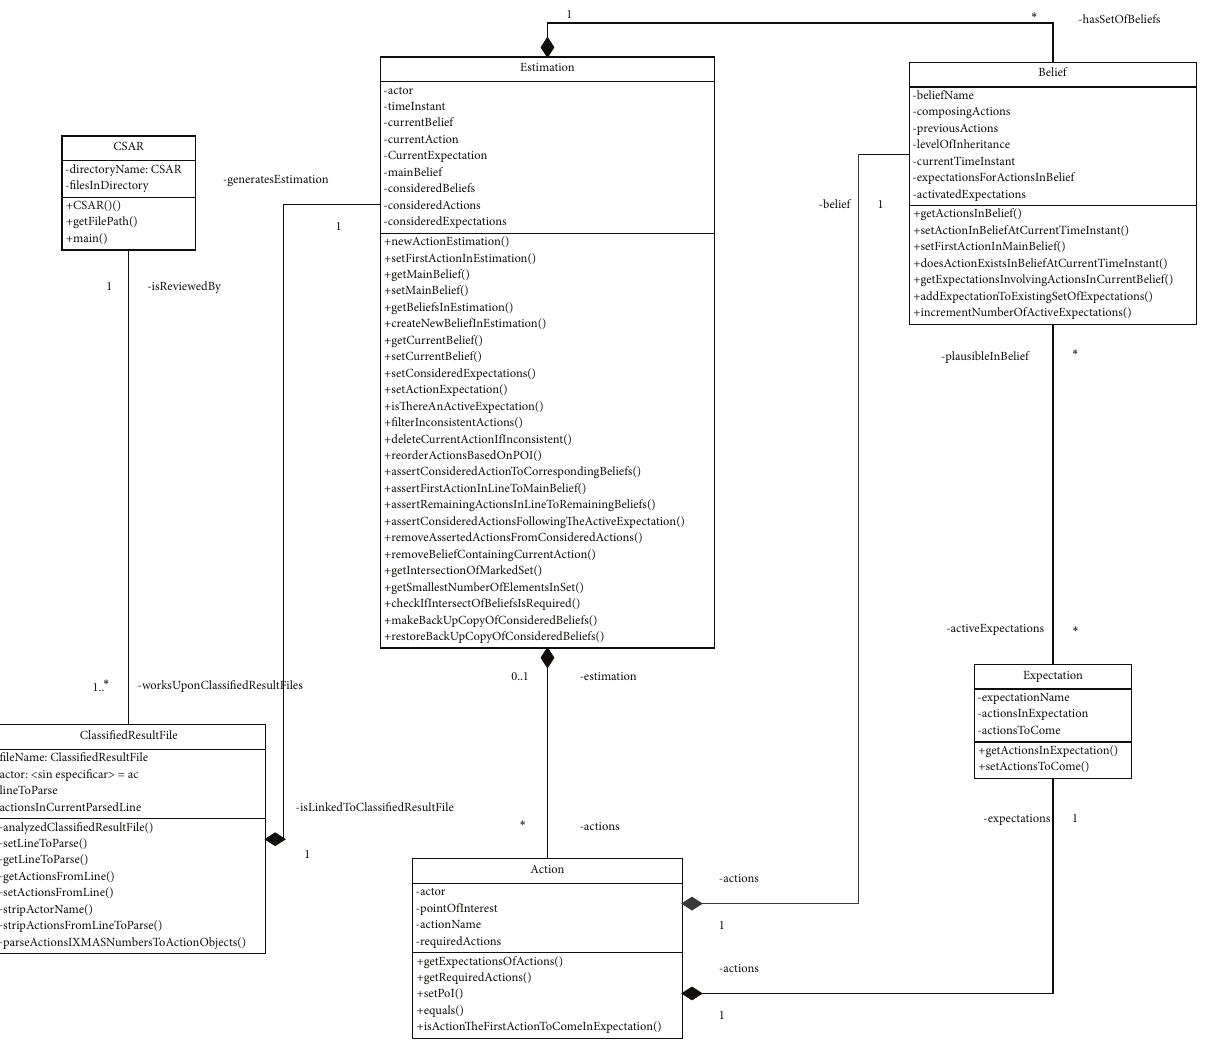
Figure 6: Class diagram for the common-sense reasoning